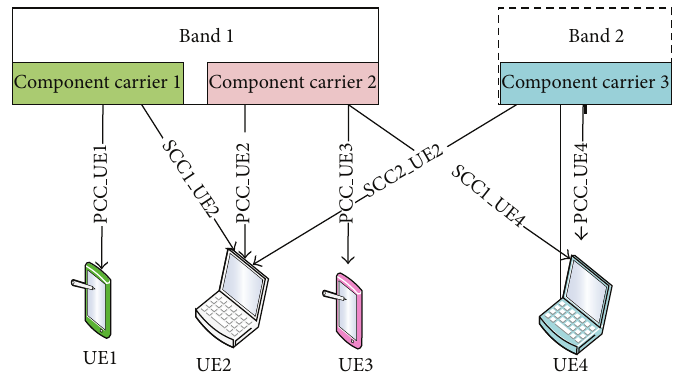
Figure 1: Configuration of CCs for different UEs served by the same